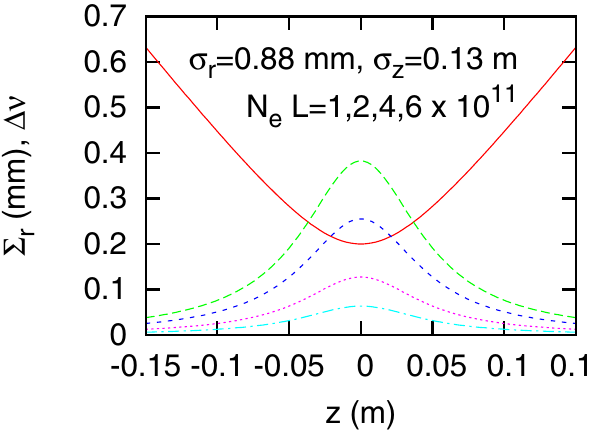
FIG. 1. (Color) Model of cloud size and tune